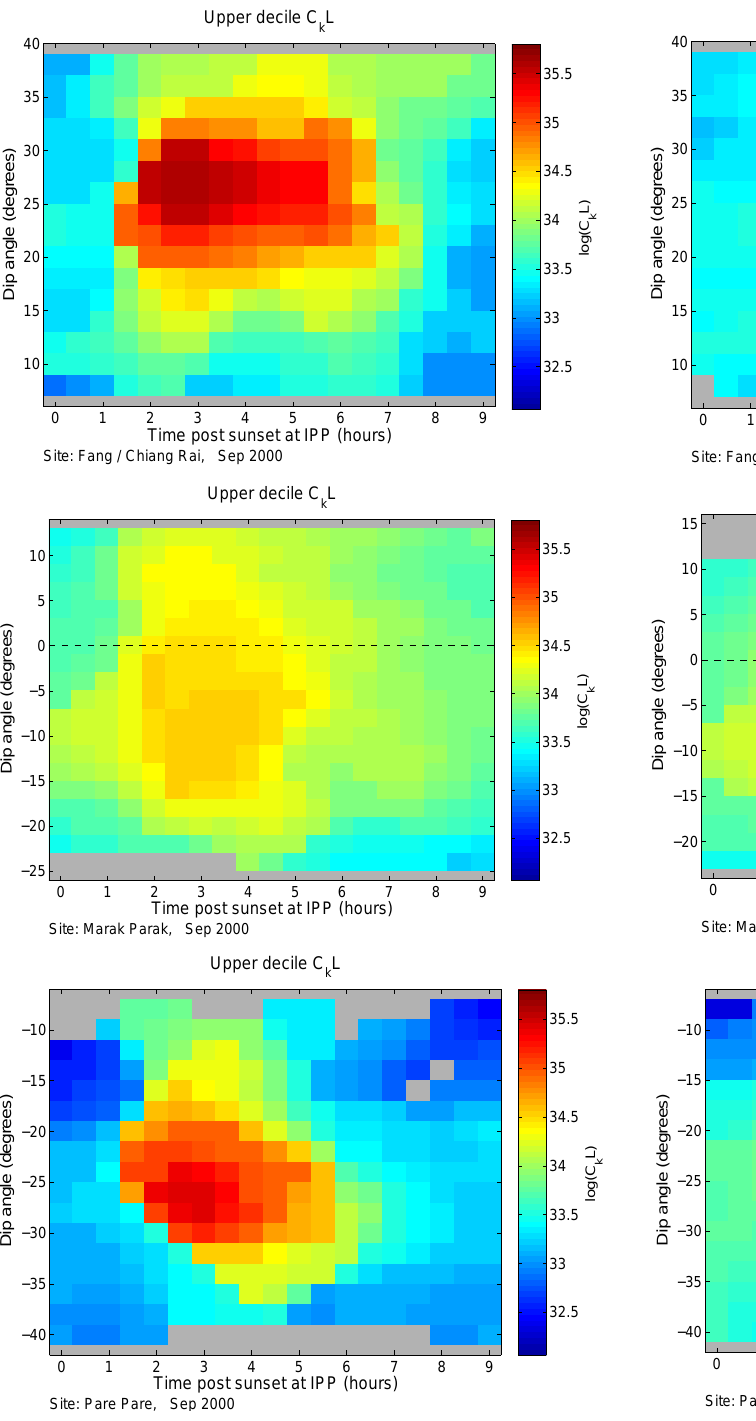
Fig. 6. Upper decile C k L , March 2001, at Chiang-Rai (top), Marak Parak (middle) and Pare Pare (bottom). The dashed line indicates the magnetic